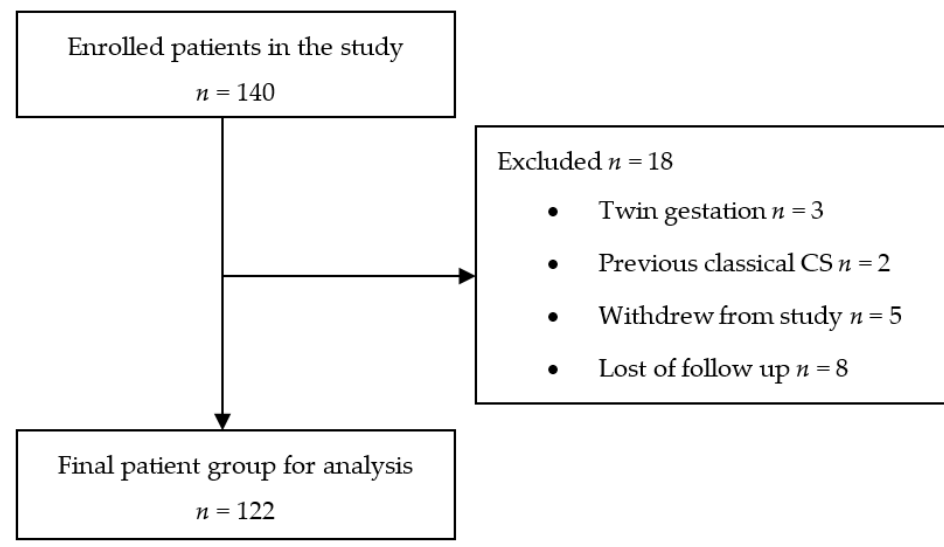
Figure 1. Flowchart of the patients enrolled in the study.